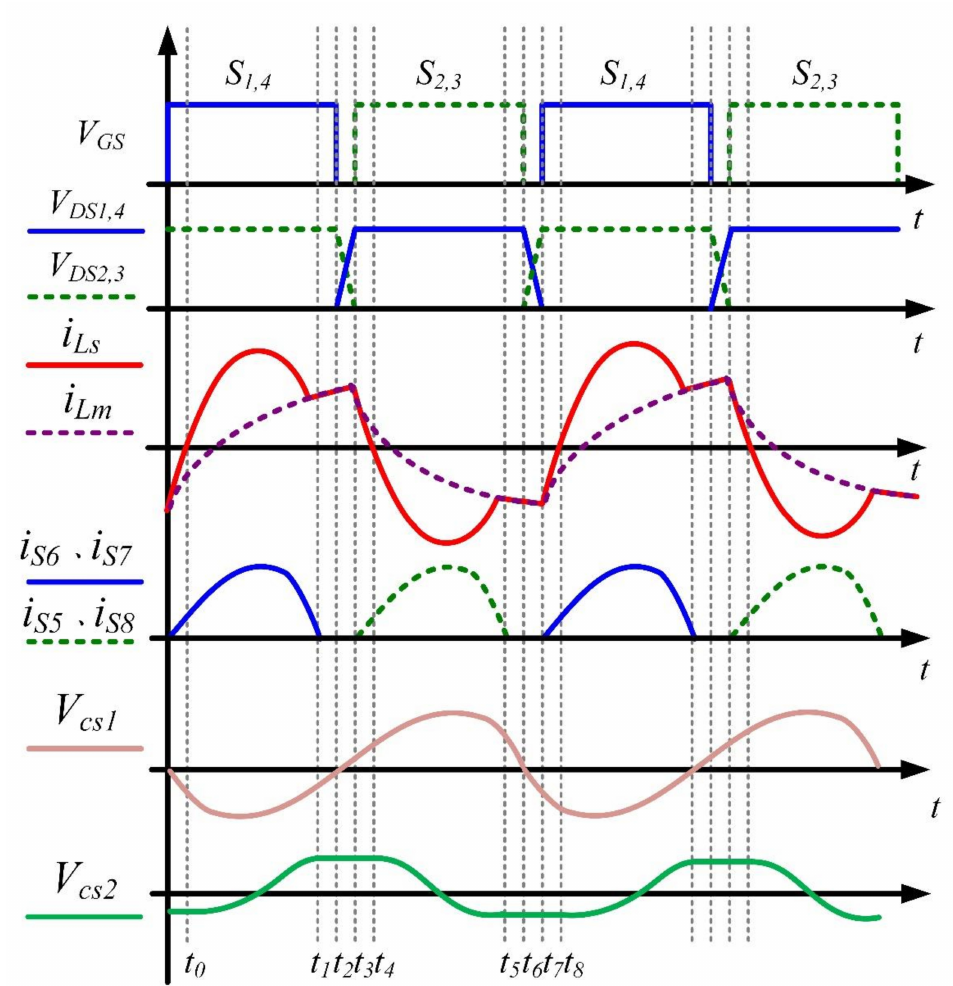
Figure 5. The timing diagram of the bidirectional full-bridge LLC resonant converter using an MT-4 resonant tank.